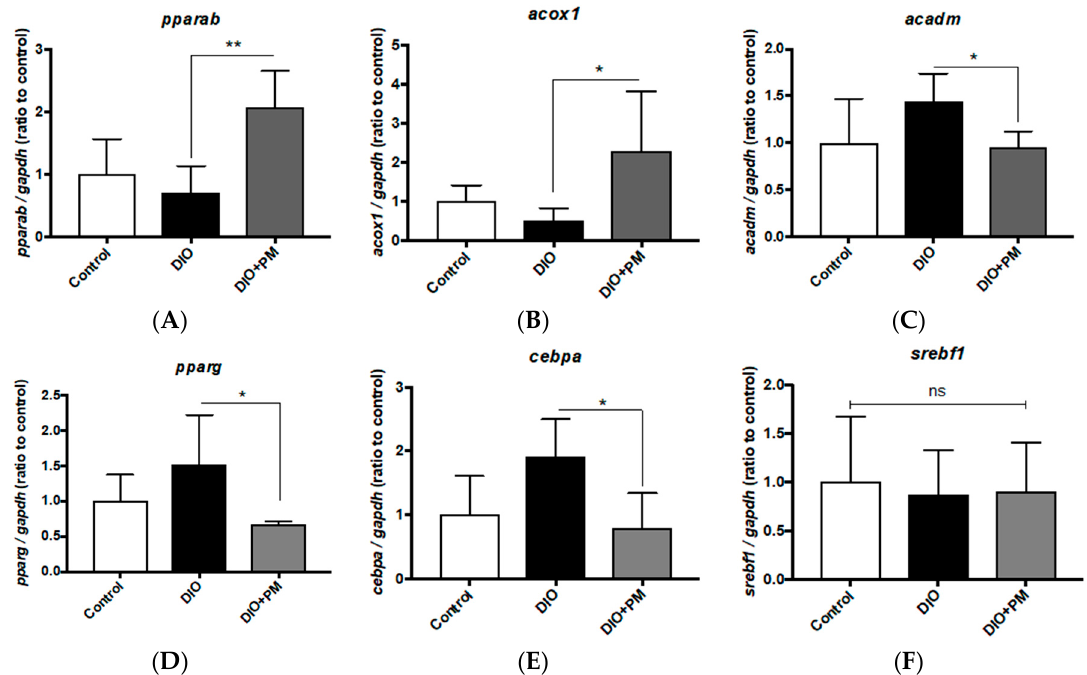
Figure 4. PM-induced gene expression changes in liver tissues of zebrafish. ( A – C ) PM effects on gene expression related to beta-oxidation in zebrafish. PM up-regulated pparab ( A ) and acox1 ( B ) expressions, in contrast to the downregulation of acadm ( C ). ( D – F ) PM effects on gene expression related to lipogenesis in zebrafish. PM suppressed DIO-induced upregulation of pparg ( D ) and cebpa ( E ), not of srebf1 . * p < 0.05, ** p < 0.01. n = 5, error bars indicate SD. pparab : peroxisome proliferator ‐ activated receptor alpha b ; gapdh: glyceraldehyde ‐ 3 ‐ phosphate dehydrogenase; acox1 : acyl ‐ CoA oxidase